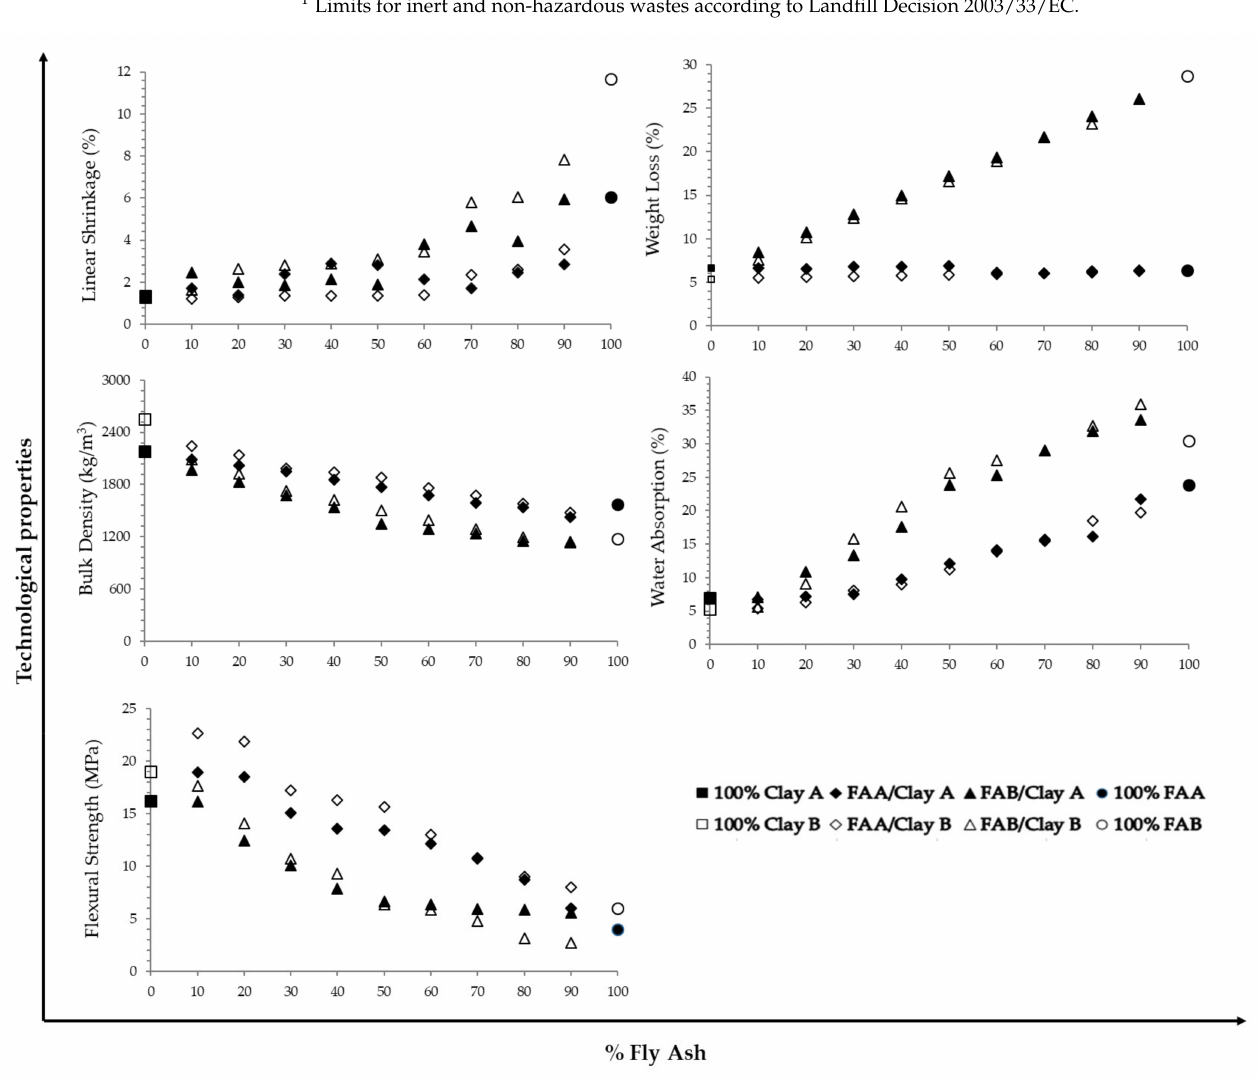
Figure 5. Main technological properties of fired clay